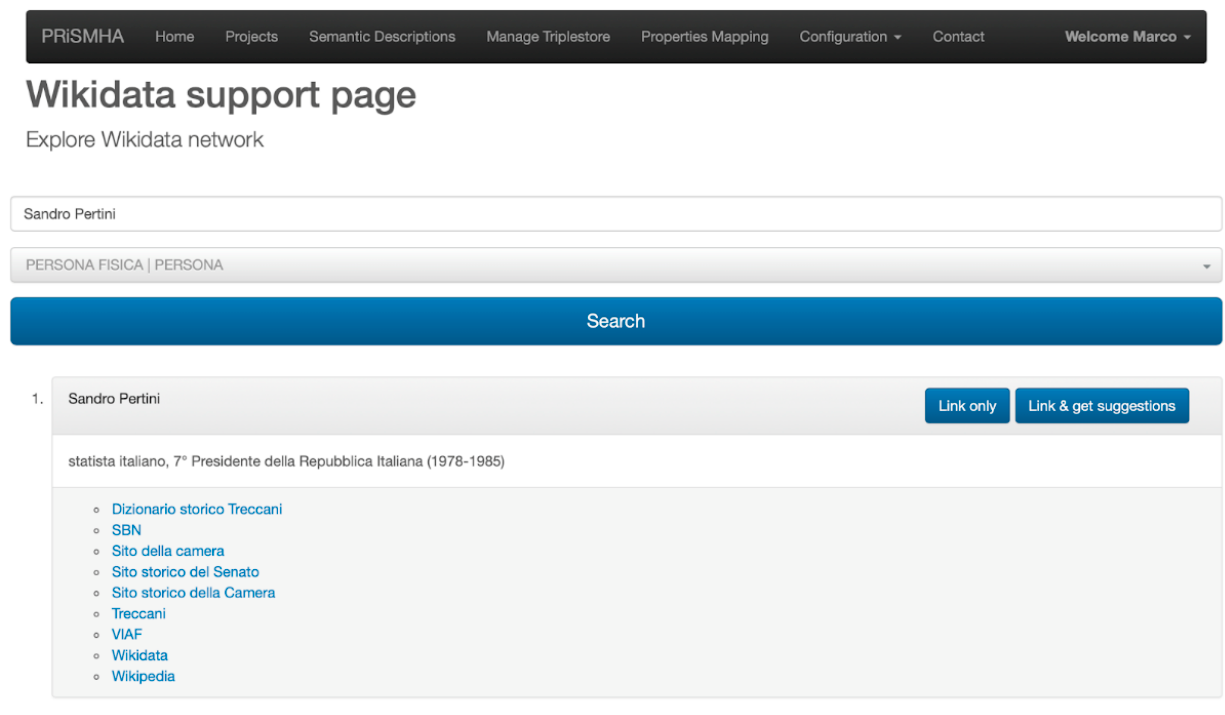
Figure 10. The Wikidata support page. In this example, we looked for an entity of type PhysicalPerson and labeled “Sandro Pertini”.